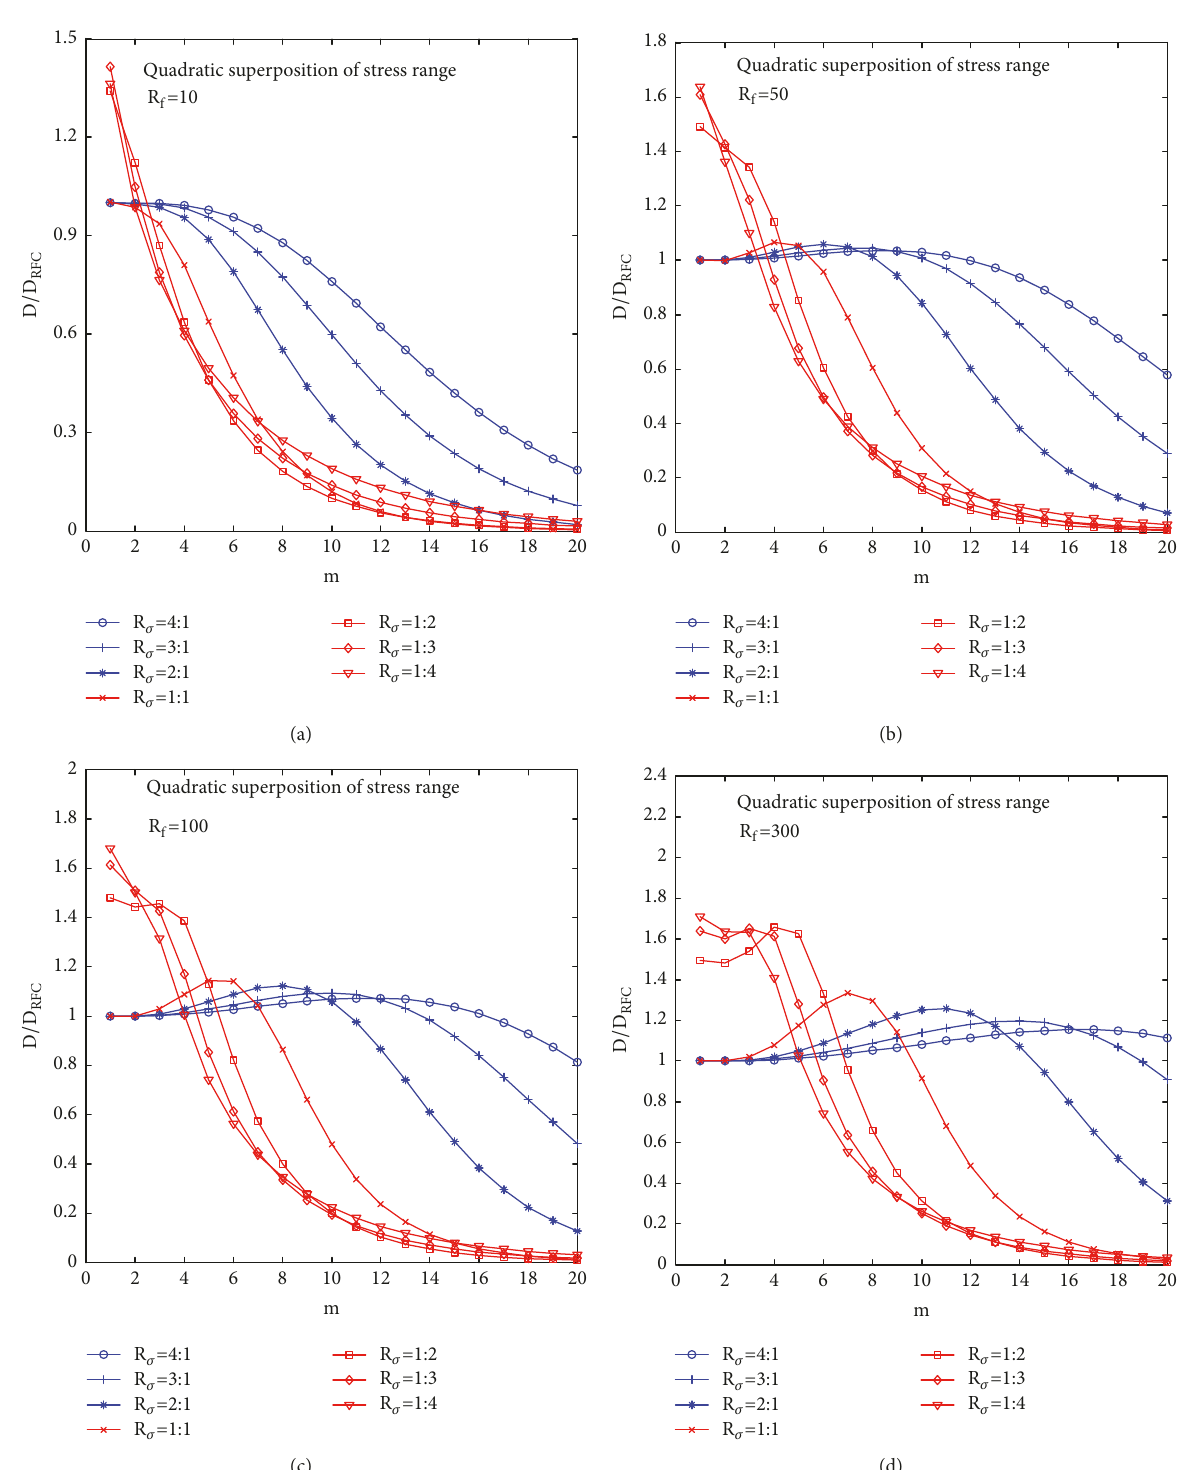
Figure 5: Damage estimation by direct quadratic superposition of equivalent stress ranges method in the case of (a) 𝑅 𝑓 = 10 , (b) 𝑅 𝑓 = 50 , (c) 𝑅 𝑓 = 100 , and (d) 𝑅 𝑓 = 300